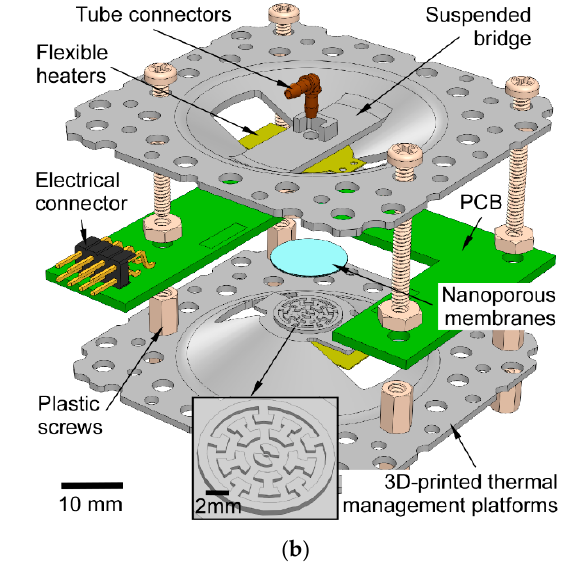
Figure 1. A 3D model of the 3D-printed bidirectional Knudsen pump: ( a ) full assembly; ( b ) exploded view. The architecture sandwiches the pumping element (a stack of nanoporous membranes) between two identical 3D-printed thermal management platforms.